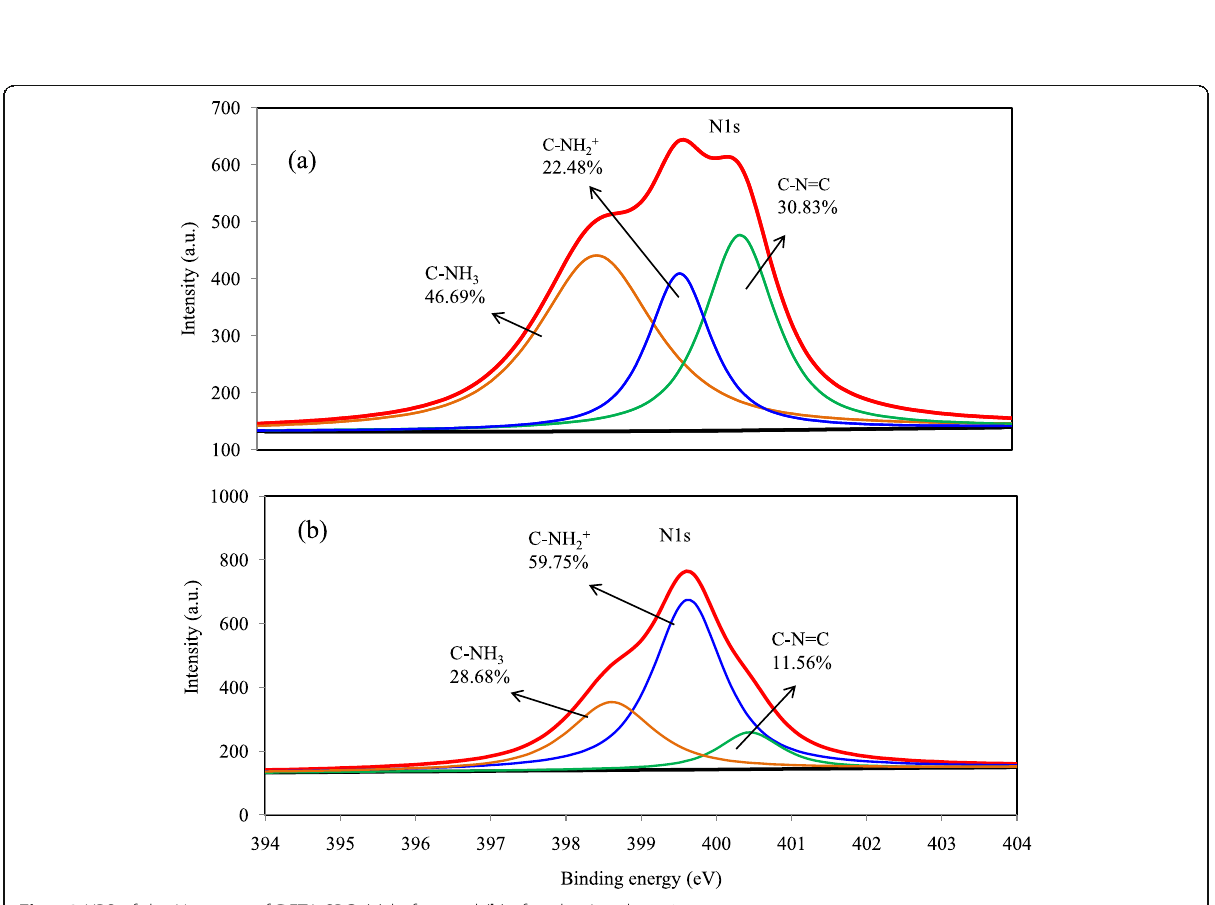
Fig. 13 XPS of the N1s state of DETA-SBC: ( a ) before and ( b ) after the As